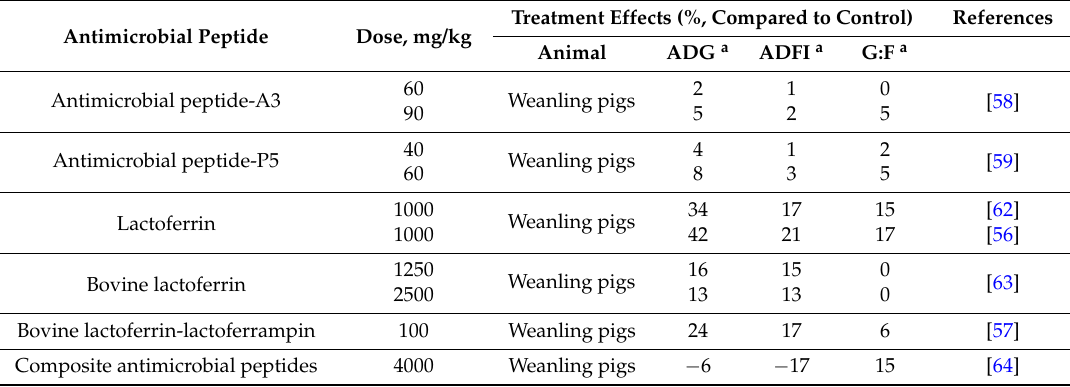
Table 1. Effects of antimicrobial peptides on the growth performance of swine and poultry. Treatment Effects (%, Compared to Antimicrobial Peptide Dose, mg/kg